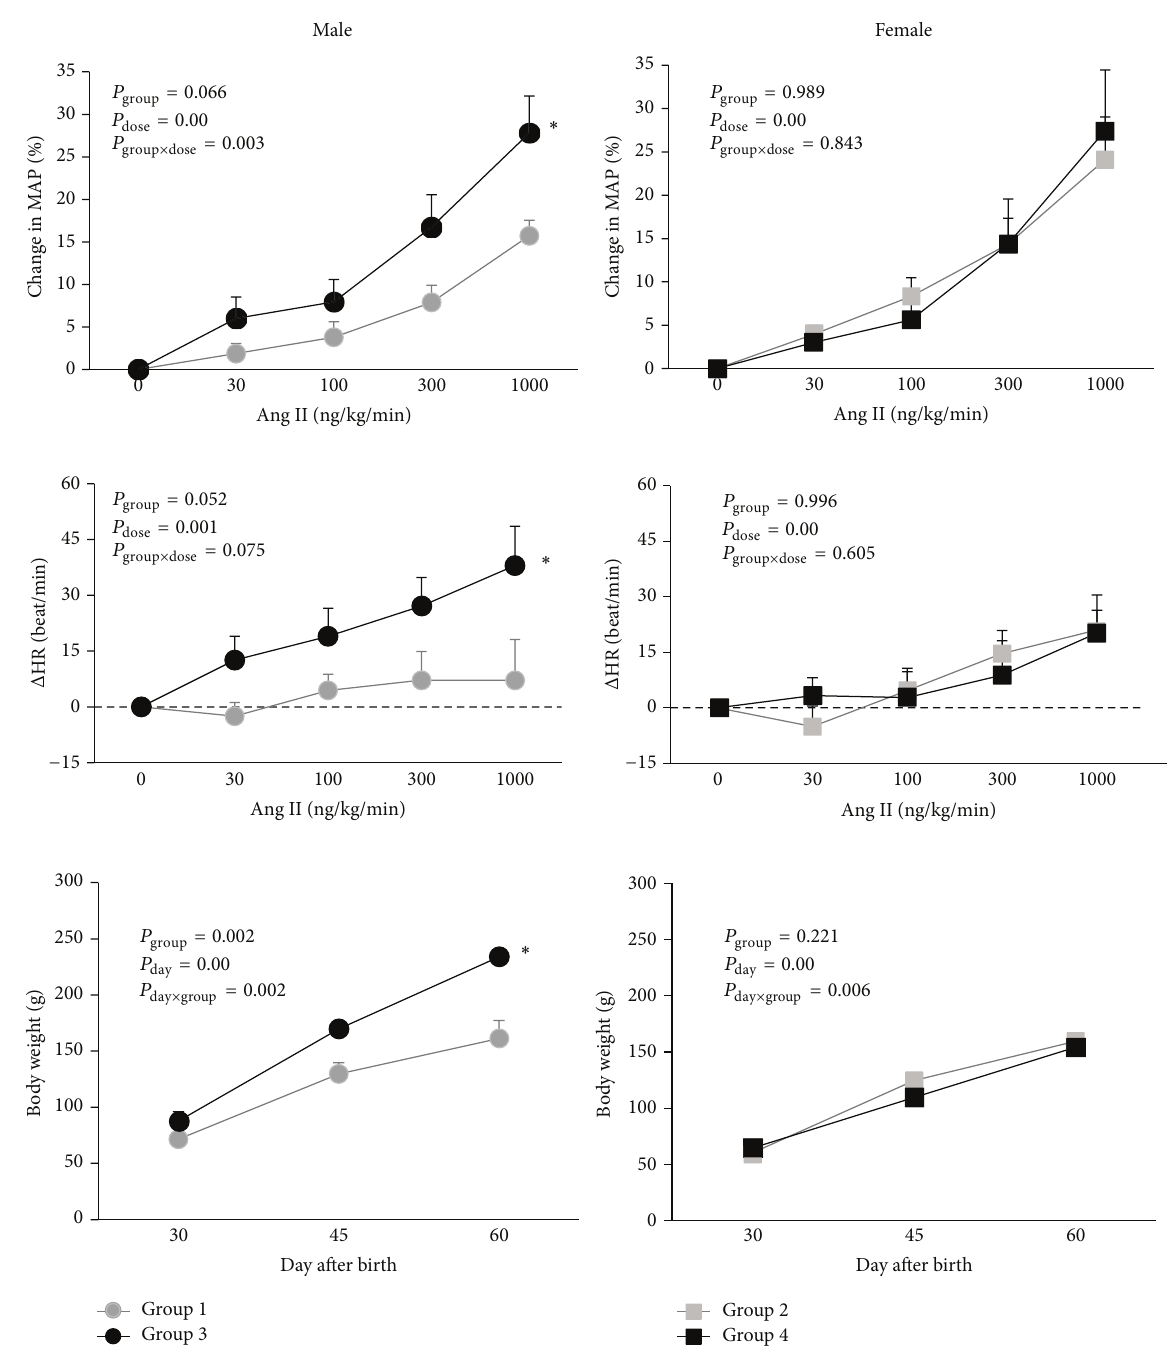
Figure 1: MAP and HR responses to AngII and body weight change in male (groups 1 and 3) and female (groups 2 and 4) offspring (adult). The star ( ∗ ) indicates significant difference from group 1. Groups 1 and 2: male (group 1) and female (group 2) offspring from mothers who received tap water during pregnancy. Groups 3 and 4: male (group 3) and female (group 4) offspring from mothers who received high-salt water during